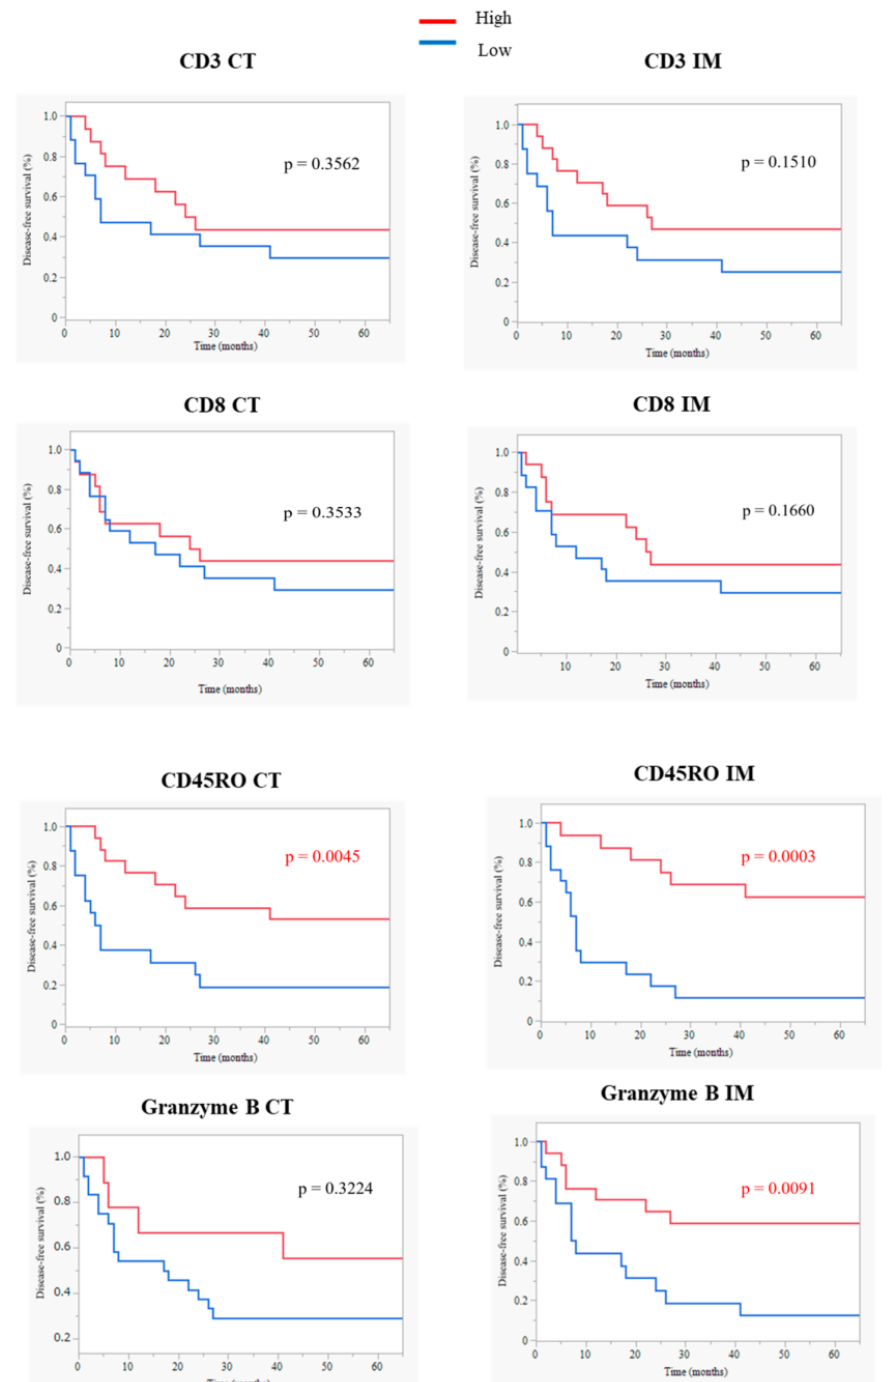
Figure 3. Kaplan–Meier curves of disease-free survival according to the TIL density in OSCC tissue. Each graph showed disease-free survival (DFS) of OSCC patients with high (red line) and low (blue line) numbers of CD3 + , CD8 + , CD45RO +, and Granzyme B + /TILs in the CT (left panels) or IM (right panels) areas. Kaplan–Meier curves of DFS indicate that patients with CD45RO + /TILs High CT ( p = 0.0045) and IM ( p = 0.0003) and Granzyme B + /TILs High IM ( p = 0.0091) exhibited significantly improved DFS. Differences were determined using a log-rank test. Statistically significant difference at p < 0.05 (red values).